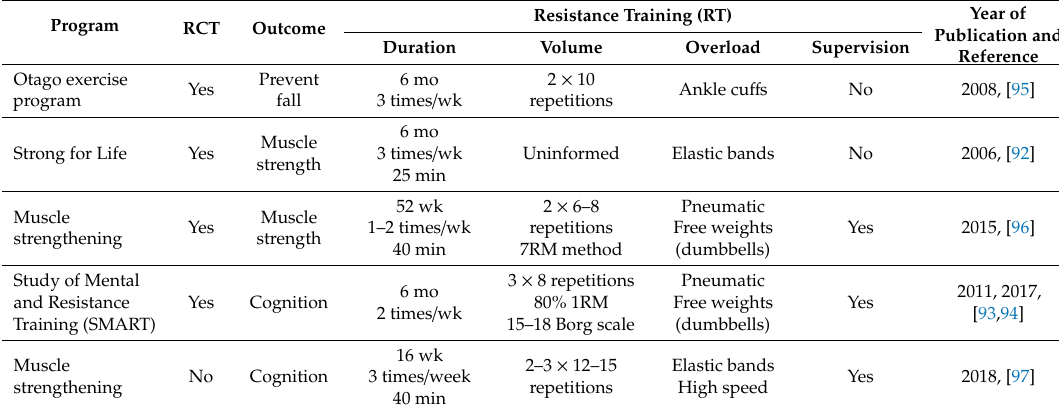
Table 2. Resistance training for cognitive enhancer e ff ects in the